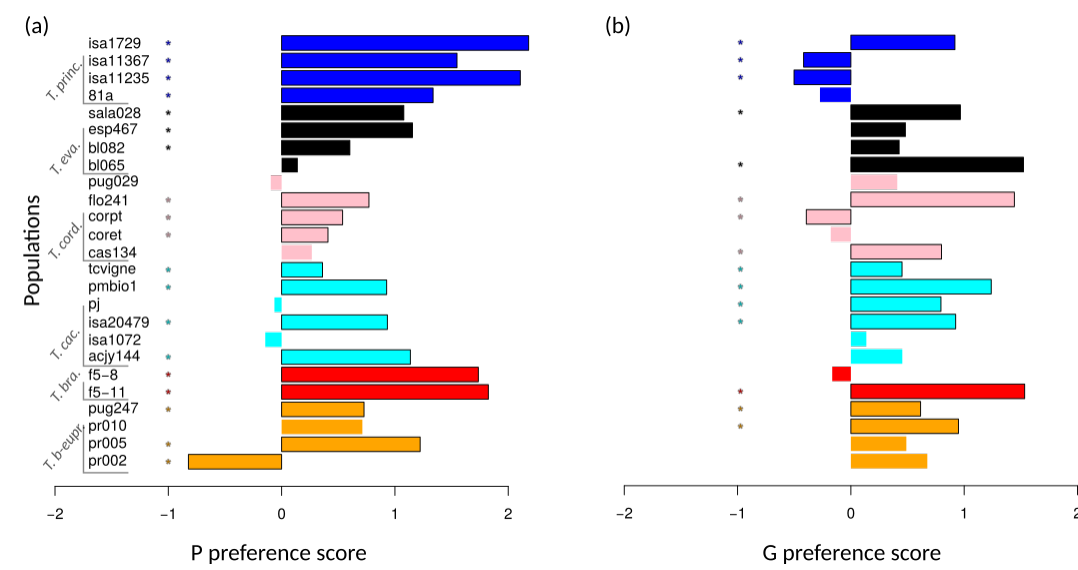
Figure 2. Preference scores for all 25 populations, in (a) “P” treatments (horizontal tubes with light/obscurity choice) and (b) “G” treatments (vertical tubes with light everywhere). Positive scores indicate preference in the expected direction (for light and upward positions, respectively). Values significantly different from zero after correction for multiple tests are highlighted with an asterisk and a dark frame. Colors correspond to different species (see Table